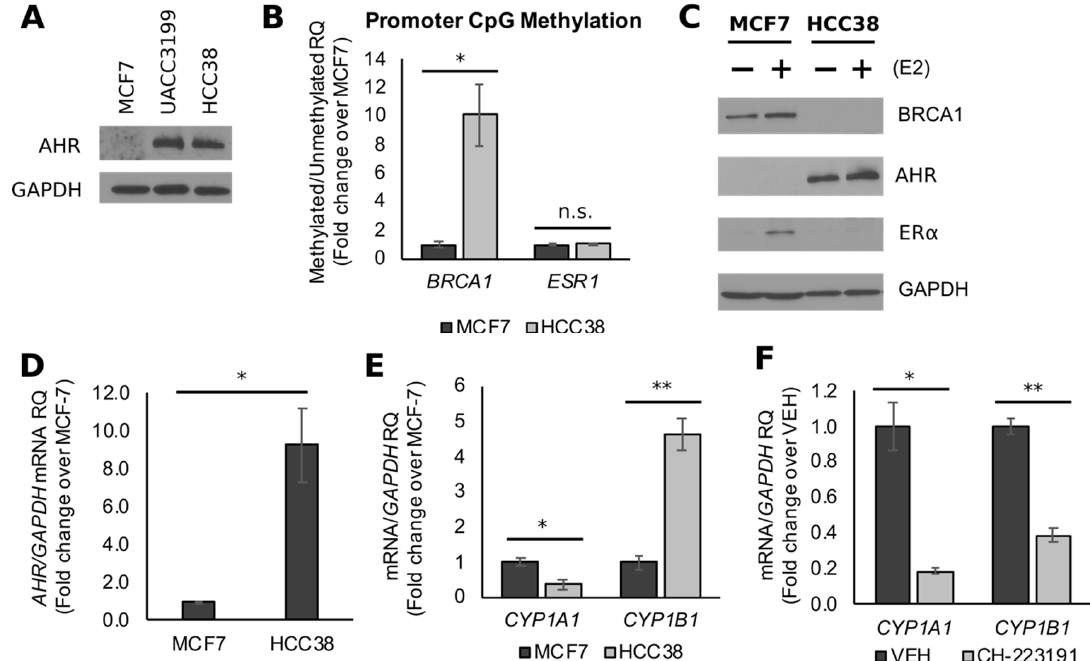
Figure 2. BRCA1 CpG hypermethylation associates with constitutively active AHR in triple negative breast cancers (TNBC) cells. ( A ) Representative Western blot images comparing immunocomplexes of AHR and internal standard glyceraldehyde 3-phosphate dehydrogenase (GAPDH) in HCC38 and UACC3199 cells. ( B ) Data from methylation-specific PCR (MSP) comparing BRCA1 and ESR1 CpG methylation in HCC38 and MCF7 cells. ( C ) Bands represent immunocomplexes for BRCA1, estrogen receptor (ER) α , AHR, and internal standard GAPDH in MCF7 and HCC38 cells. ( D ) Comparison of AHR mRNA expression in HCC38 and MCF7 cells. ( E ) Expression of AHR targets CYP1A1 and CYP1B1 in HCC38 and MCF7 cells. ( F ) CYP1A1 and CYP1B1 expression in HCC38 cells treated with the AHR antagonist CH-223191. Bars represent sample means ± SEM from ≥ 3 biological replicates from individual experiments. VEH: vehicle-treated control. Asterisks indicate significant differences (*, p<0.05; **, p<0.01).